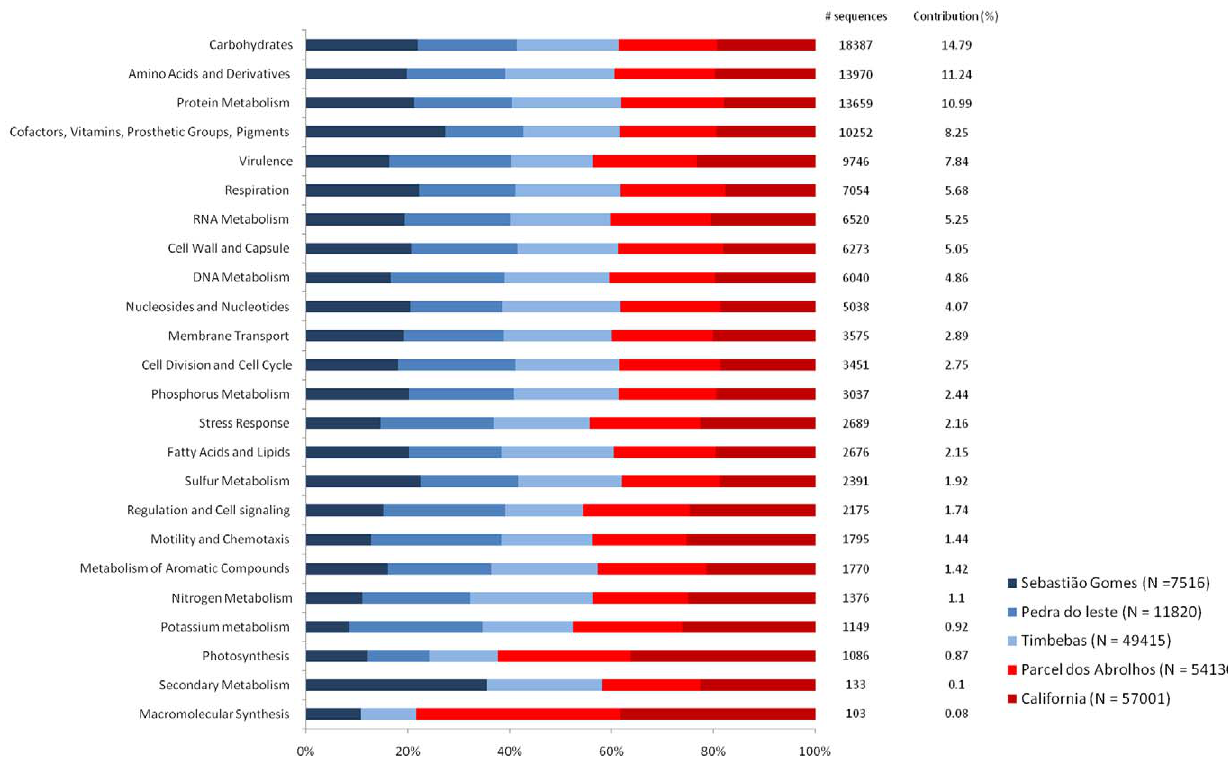
Figure 4. Contribution of the subsystems (hierarchy 1) in the different reefs. The bars indicate the participation of sequences for each subsystem in the protected and unprotected reefs. The contribution column is relative to the total number of sequences identified for each subsystem. Only informative sequences were used for subsystem identification. The sequences were assigned as Miscellaneous Subsystems, and Unknown or Clustered Based Subsystems were not included.